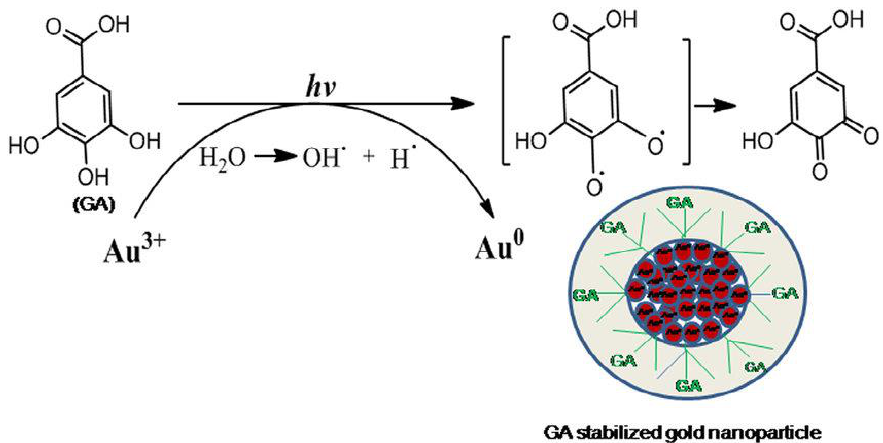
Figure 6. Diagram showing the formation of Au-nanoparticles (NPs) using GA under low-temperature sonication conditions. Adapted from Ganesh et al. [173].